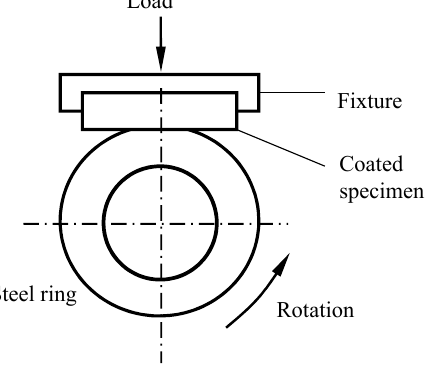
Figure 1. Schematic diagram of tribometer. Table 3. The friction test conditions.